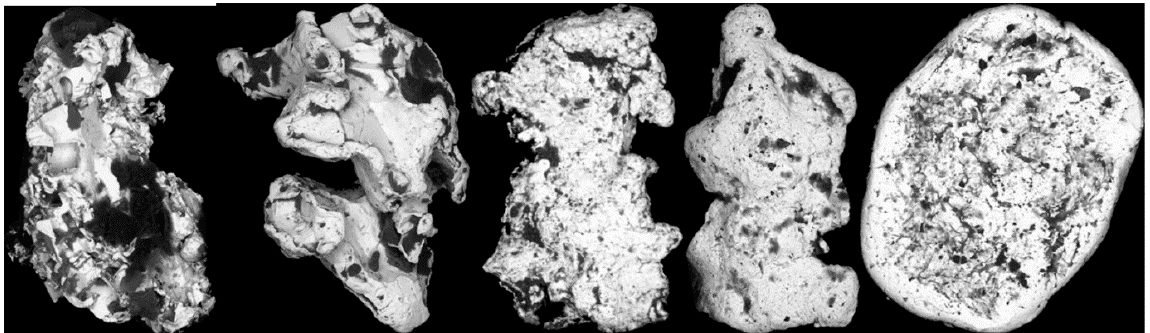
Figure 6. Examples of gold grain showing the continuum of shapes between “pristine (intergranular)” ( left ), “modified” ( center ) and “reshaped” ( right ). The grains in between can be classified as either neighboring class by different mineralogists, leading to discrepancies in the class counts. All grains are approximately 200 µm in length.